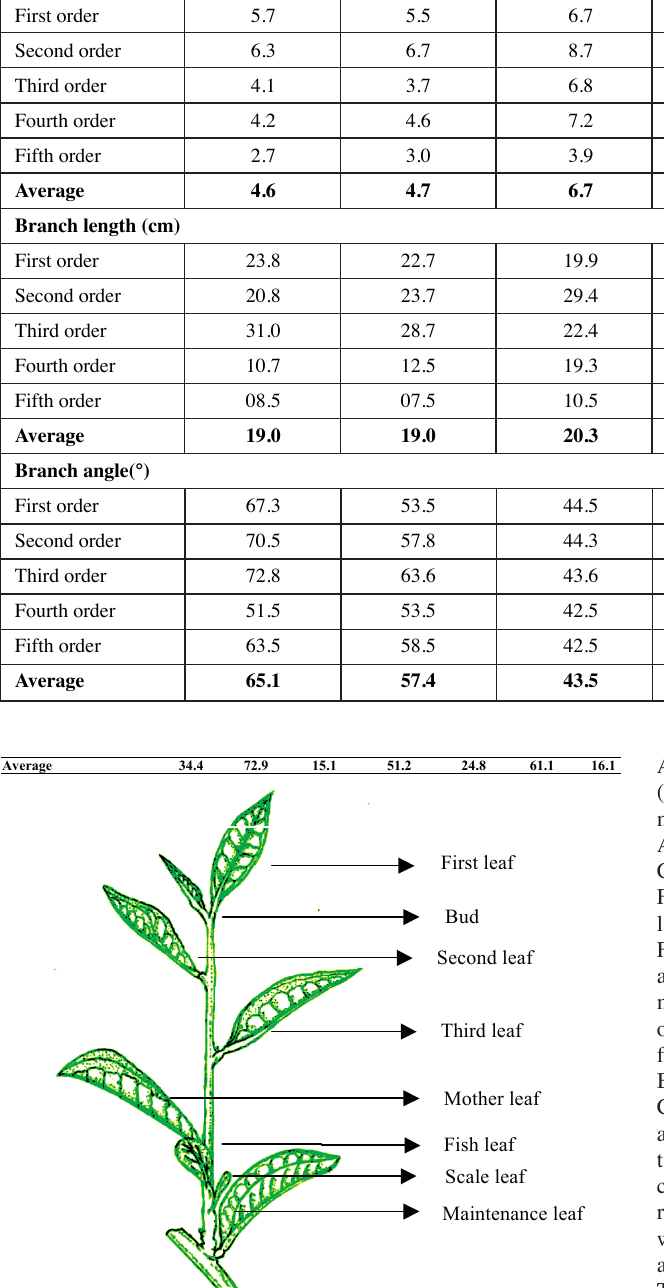
Figure 1. Shoot structure of a periodic tea shoot containing different types of leaves